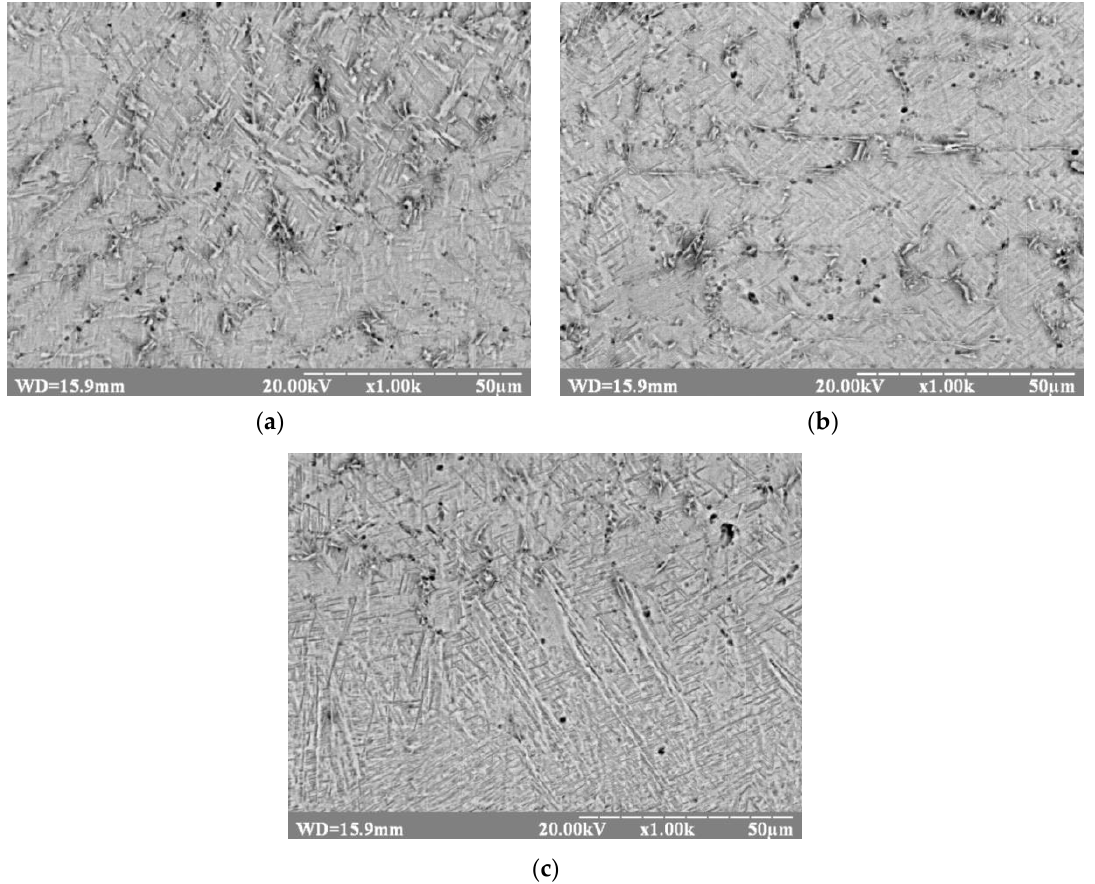
Figure 16. Structure of boride fibers’ submicron cluster network with distance from the Ti-TiB—welded